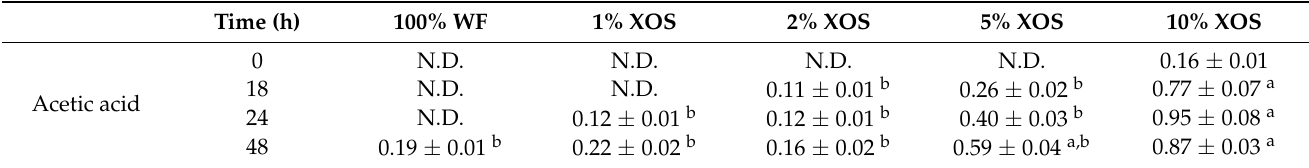
Table 2. Acetic acid (mg/L) quantity during